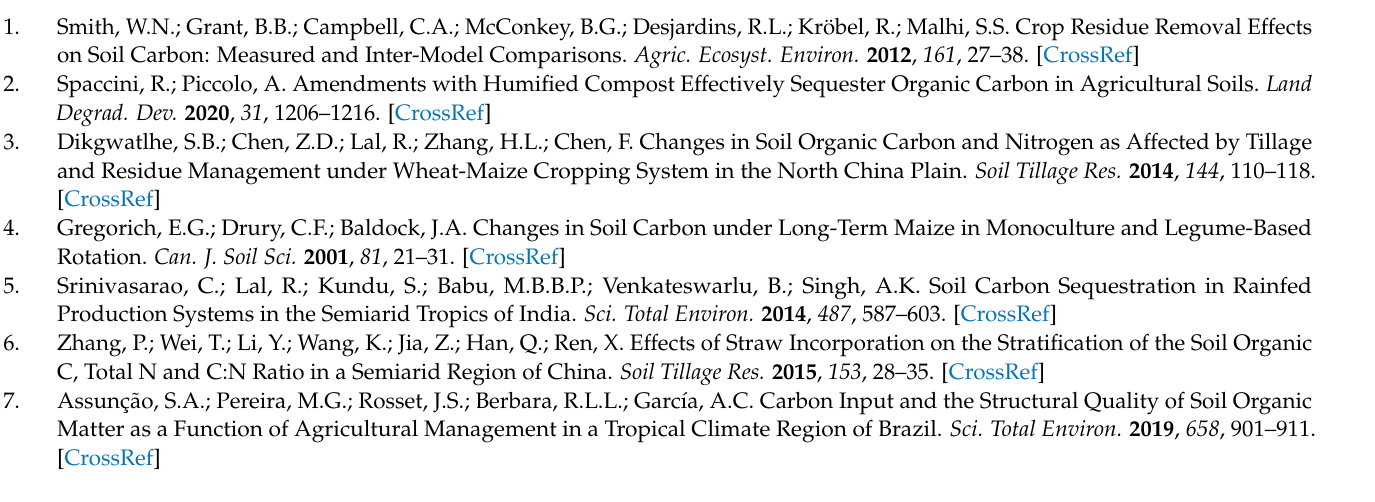
Figure S4. The average soil water content of 0 − 100 cm soil layer in the period 2016 − 2018. Figure S5. The average soil temperature of the top 5 cm soil layer in the period 2016 − 2018. Table S1. The Chao1, Shannon and Simpson indices of alpha diversity of soil bacteria as affected by the treatments determined using High-throughput 16S rDNA sequencing in 2018 (by OE Biotech Co., Ltd., Shanghai, China). Table S2. The relative abundance of the top 15 soil bacteria at the phylum level under different treatments determined by High-throughput 16S rDNA sequencing in 2018 (by OE Biotech Co., Ltd., Shanghai,